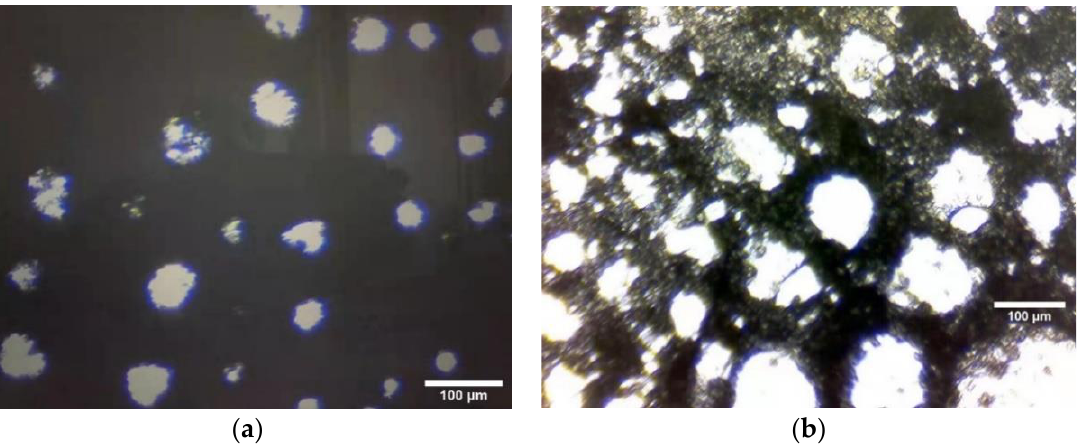
Figure 14. Electron micrographs of the pore structure of permeable cement stone (cross-section). ( a ) Without GPG. ( b ) Add 6% GPG.